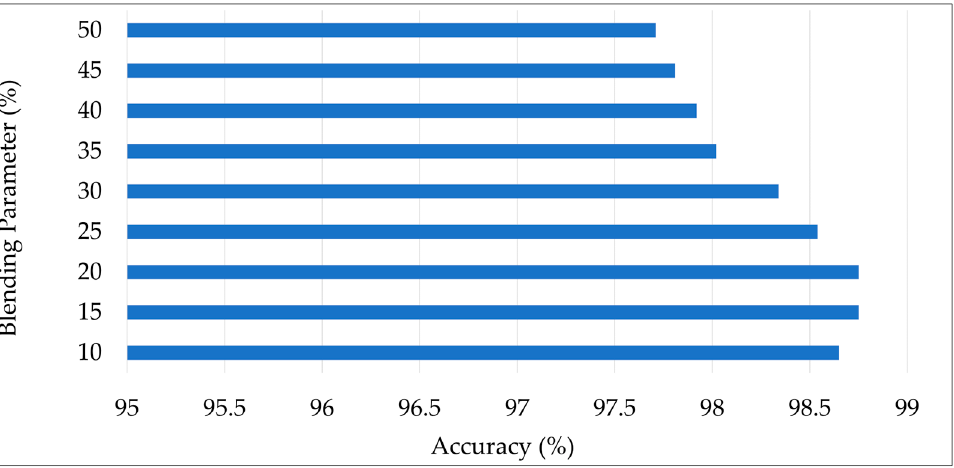
Figure 4. The accuracy values obtained by Balanced K-Star with different parameter values.